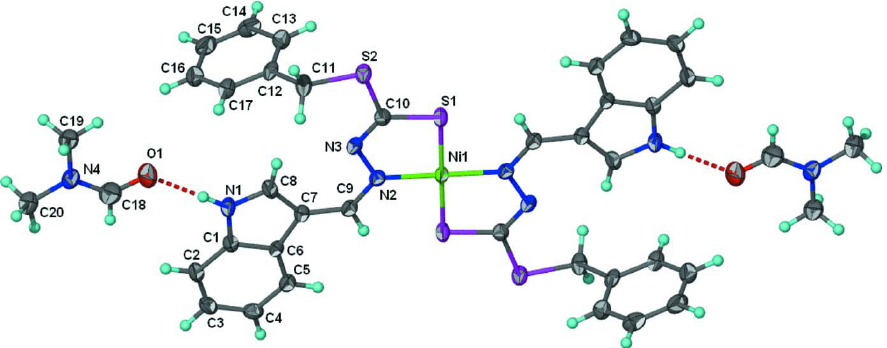
View of (I) at the 70% probability level. Hydrogen atoms are drawn as spheres of arbitrary radius. The unlabelled atoms are generated by the symmetry operation (1–x, 1–y, 1–z) and the hydrogen bonds are shown as dashed lines. Bis[benzyl N ′ -(1 H -indol-3-ylmethylene)hydrazinecarbodithioato- κ 2 N ′ , S ]nickel(II) N , N -dimethylformamide disolvate Crystal